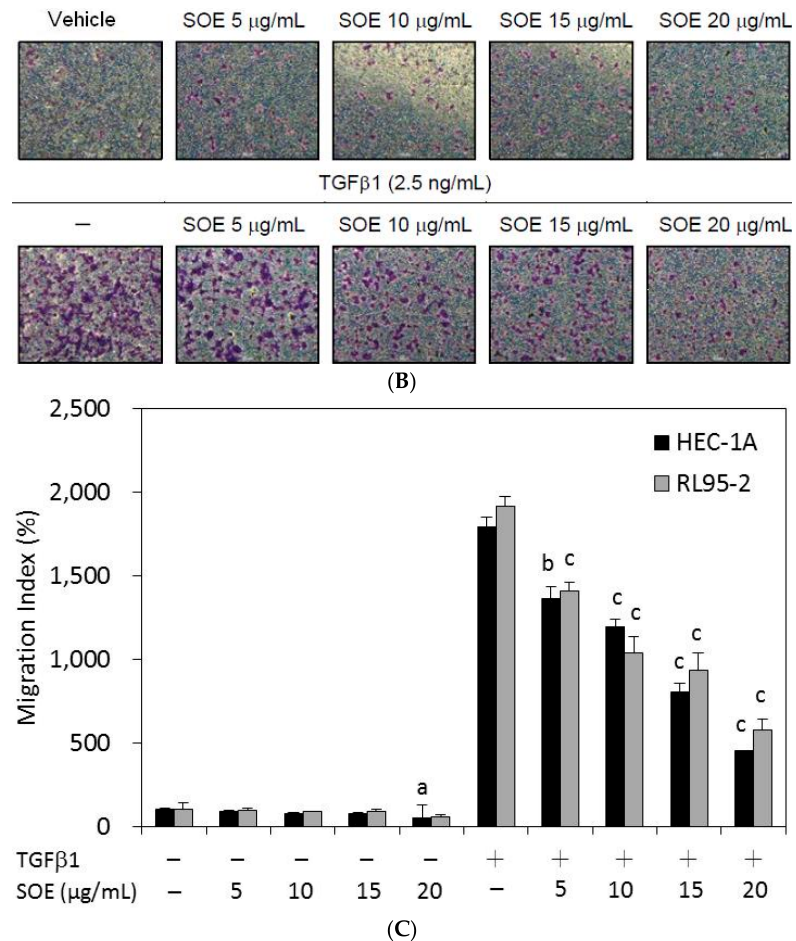
Figure 4. Effects of SOE dose on migration of endometrial cancer cells. ( A ) HEC-1A cells; ( B ) RL95-2 cells; and ( C ) the migration index of both cell lines. The migration assay was conducted using the Boyden chamber. HEC-1A and RL95-2 cells were treated with various doses of SOE for 48 h. Cells that penetrated the polycarbonate membrane to lower surface of the filter were stained with 0.5% crystal violet. The cell numbers were visualized under an inverted microscope with a magnification of 100× and were counted per field. The migration index is defined as 100% without TGF β 1 induction and without SOE treatment. Three independent experiments were performed; results are expressed as mean ± SD. A significant difference from the respective vehicle, according to Student’s t -test, was indicated as “a” for p < 0.05, “b” for p < 0.01, and “c” for p < 0.001.